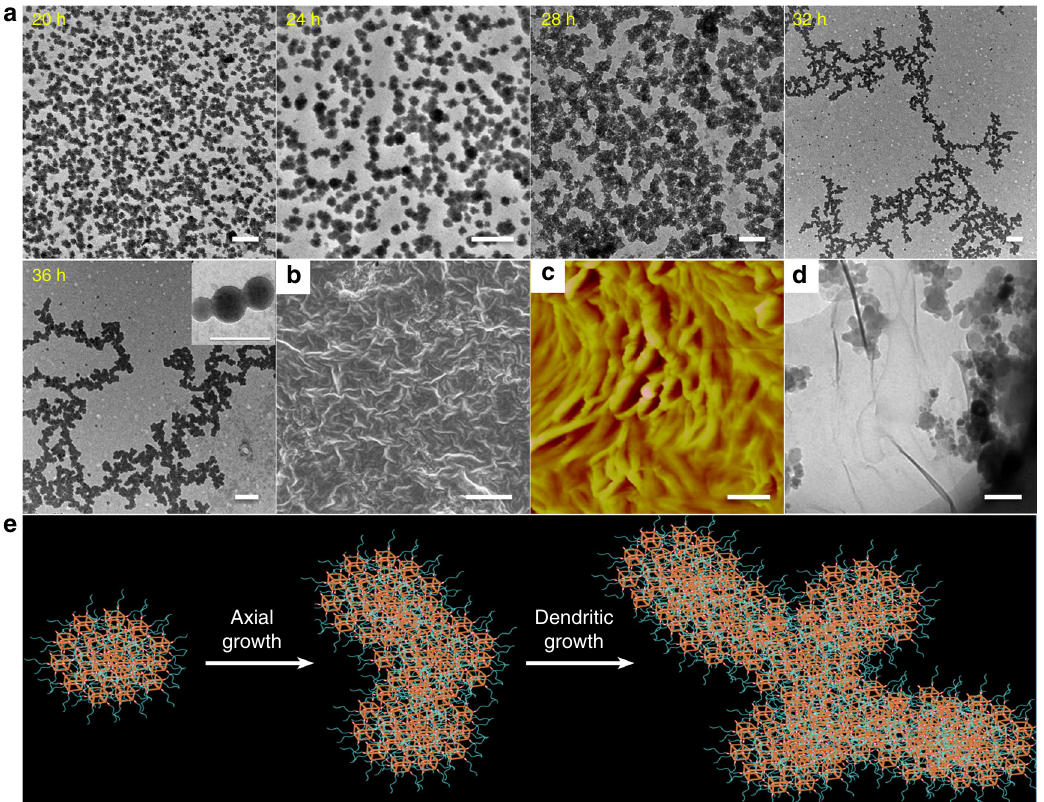
Fig. 6 Hierarchically nanostructural orientation of axial and dendritic growth at microscales and macroscales. After neutralizing the aqueous solution and removing the by-products before dialysis, all the samples are prepared from the neutralized aqueous solution unless otherwise noted. a TEM images showing the self-assembled evolution of POSS-SS-(PEG) 8 with the concentration of 1 mg/mL in pH 8 solutions for various times. The inset is the high magni fi cation image of worm-like formations at 36 h, intuitively proved the interconnect arrangement of self-assemblies. b SEM, c AFM, and d Cryo-TEM images of the worm-like formations at 36 h. Scale bars: 0.5 μ m. e The possible self-assembled mechanism of nanostructural growth with axial and dendritic directions. In this process, the large scale nanoparticles are still grown toward the axial orientation roughly at fi rst, but fi nally formed the dendritic worm- like micelles with large size. The complex architectures, giant surface areas and reduced hydrophilic layers of the spheres provide more chances for the side-crosslinking to form the dendritic conformations. The orange cube represents the POSS core, the red ellipsoid represents the disul fi de linkage and the cyan chain represents the PEG